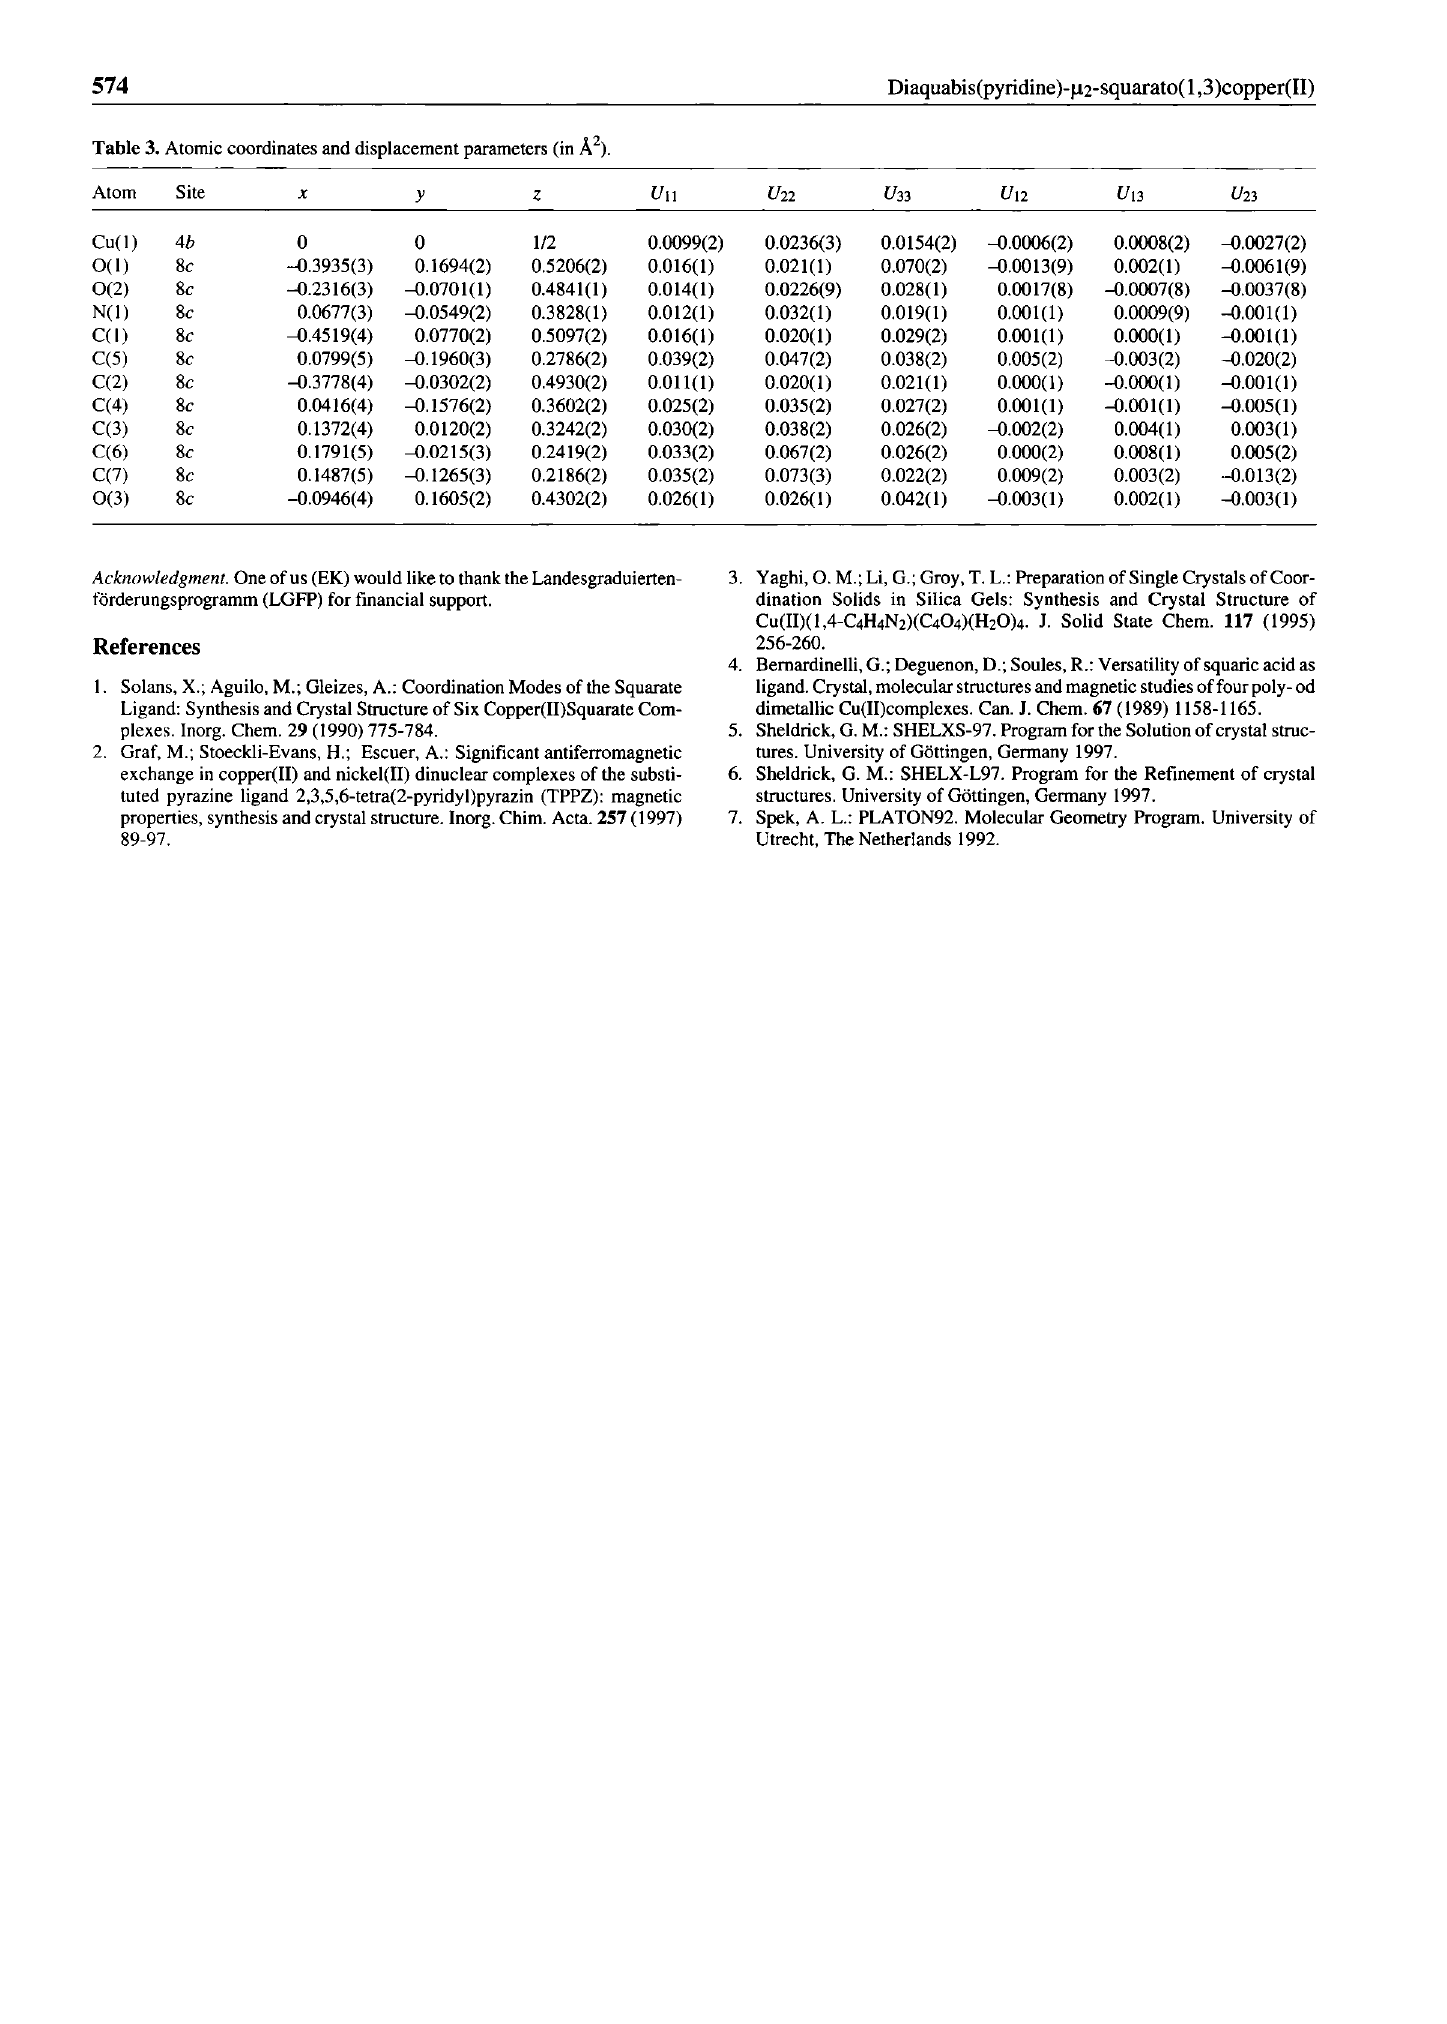
Table 3. Atomic coordinates and displacement parameters (in Â 2